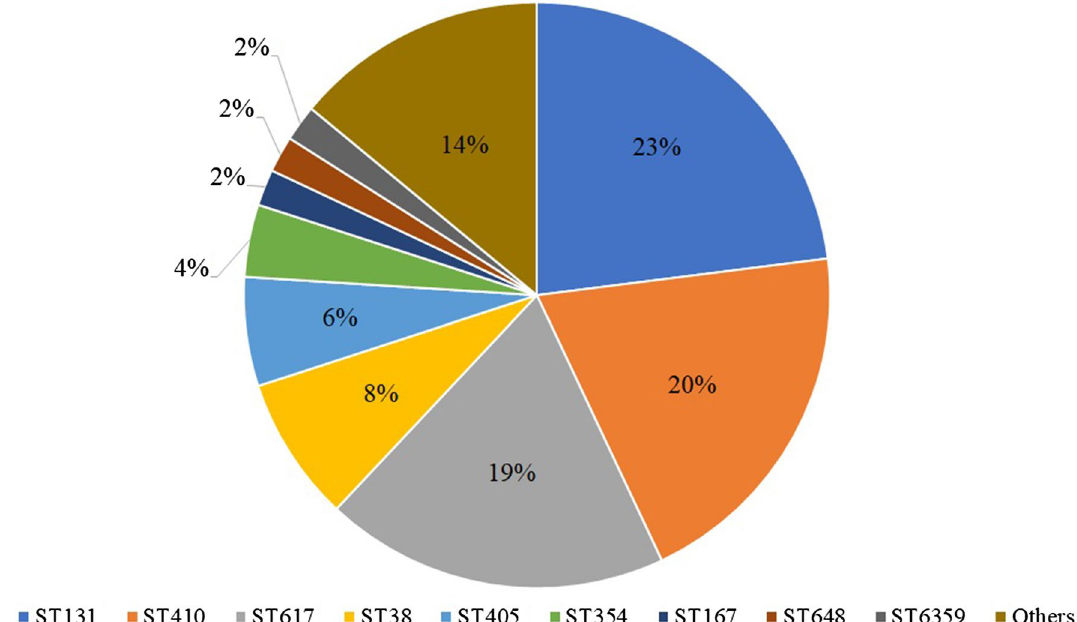
Figure 1. Distribution of sequence types (STs) among 102 extended-spectrum beta-lactamase (ESBL) producing Escherichia coli isolates. Isolates grouped as others belong to ST10, ST44, ST156, ST361, ST448, ST744, ST940, ST1303, ST1722, ST1727, and ST1788.